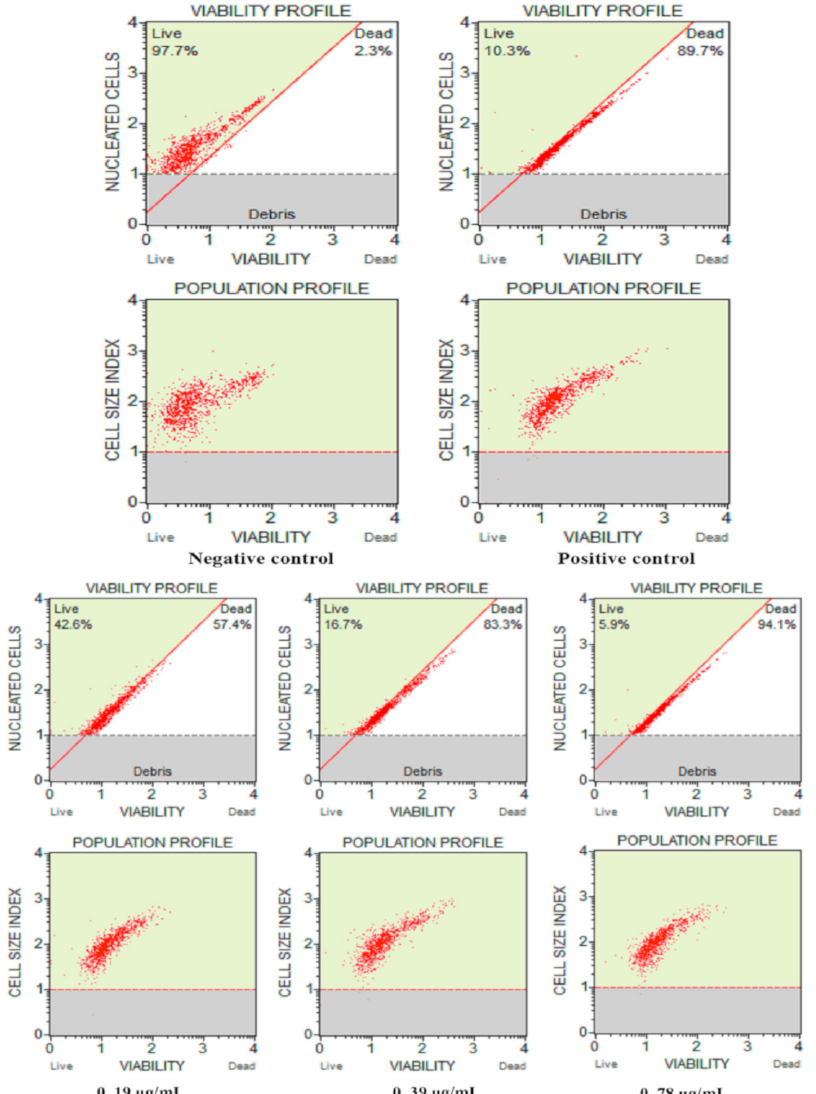
Figure 5. Effects of Ag–Fe NPs on the viability and cell count of C. auris MRL6057. Untreated and cells treated with 10 mM H 2 O 2 represent negative and positive controls respectively. For treatment, C. auris cells were exposed to different concentrations of Ag–Fe